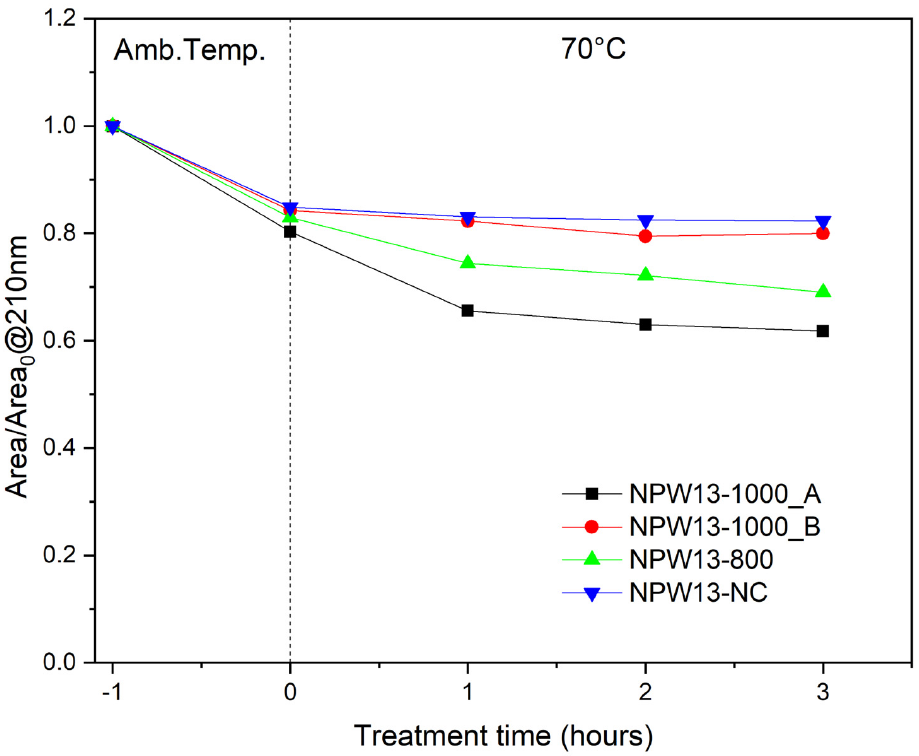
Figure 8. Orange II degradation vs. contact time in the presence of NPW13-NC and NPW13 calcined at different temperatures and prepared by Lab B, in comparison with